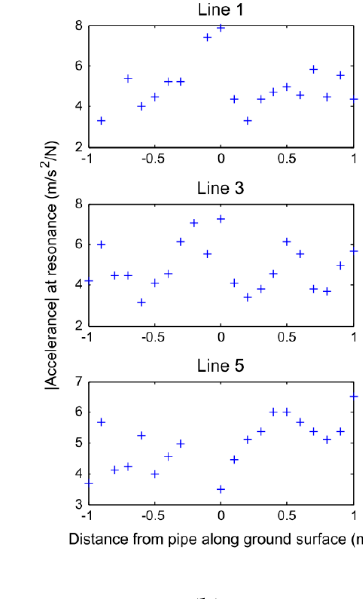
Figure 9. Point vibration measurements: ( a ) pipe rig prior to burial; ( b ) acoustic source (shaker); ( c ) measurement lines (the cross are for illustrative purposes only) [90].